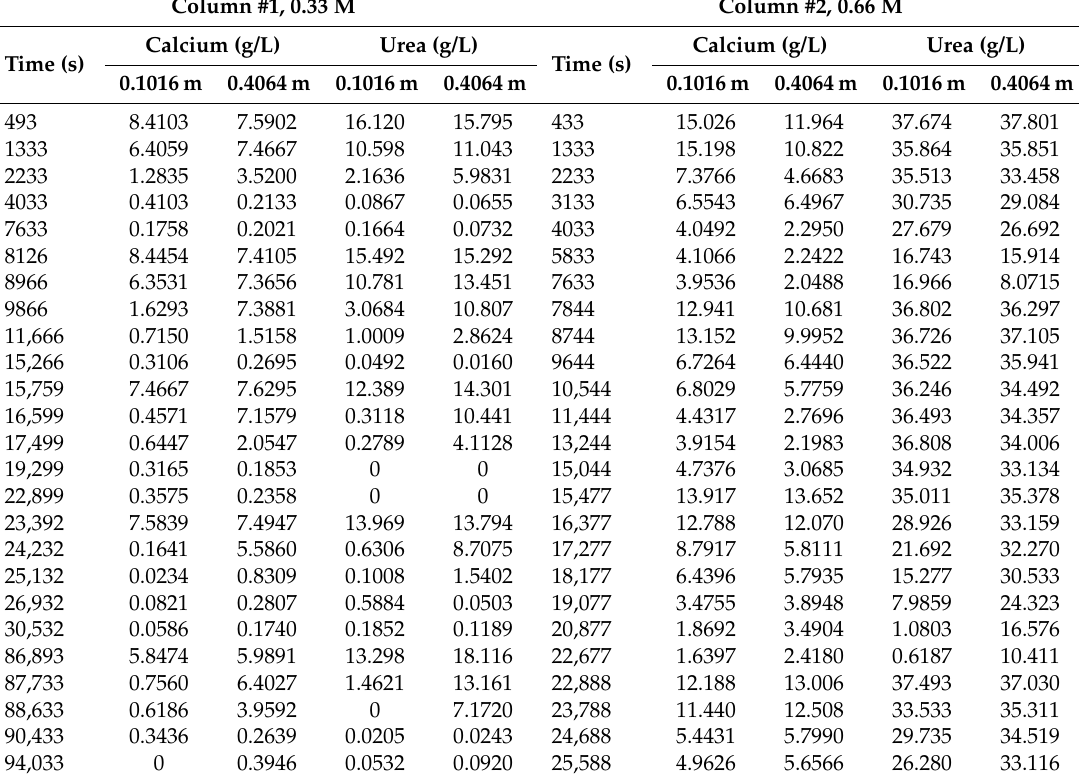
Table A1. Measured concentrations of urea and calcium for the 0.33 M and the 0.66 M column experiments at 0.1016 m and 0.4064